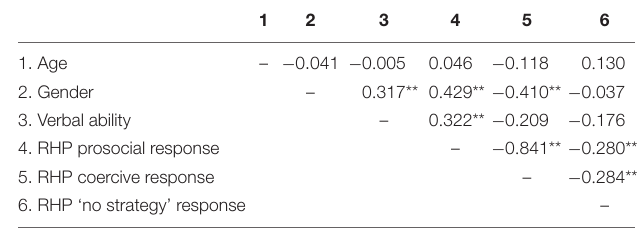
TABLE 1 | Pearson’s bivariate correlations between study